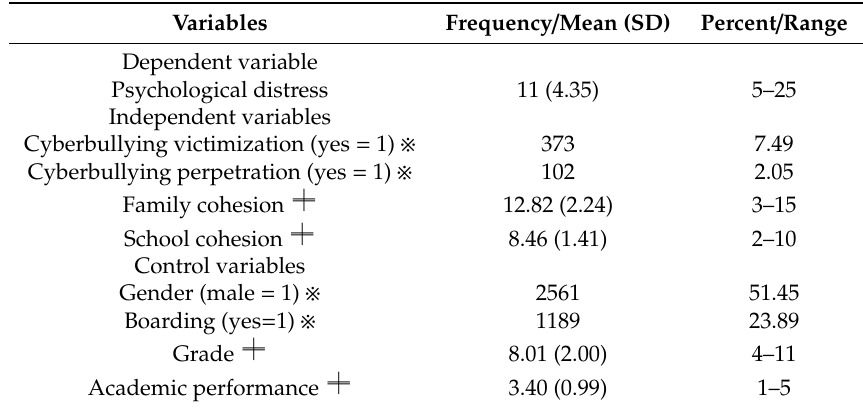
Table 1. Descriptive analysis (N = 4978).